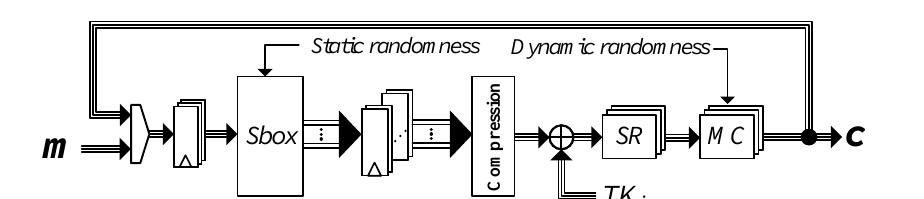
Figure 5: Design architecture of our round-based second-order Skinny -64 encryption